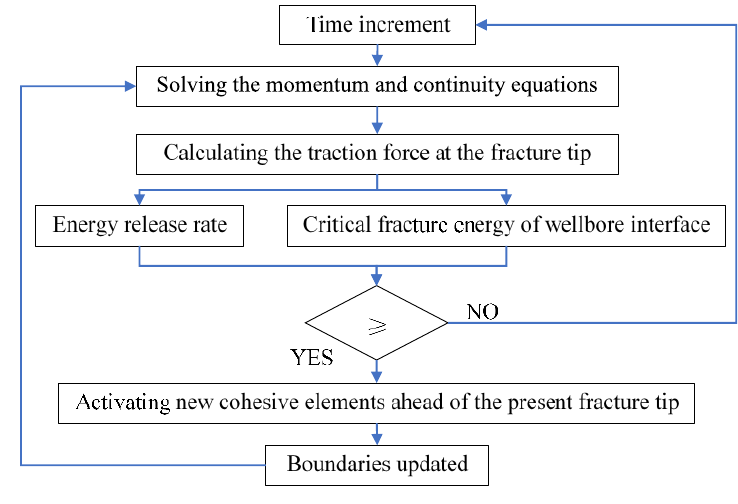
Figure 5. The solving steps of the numerical model.